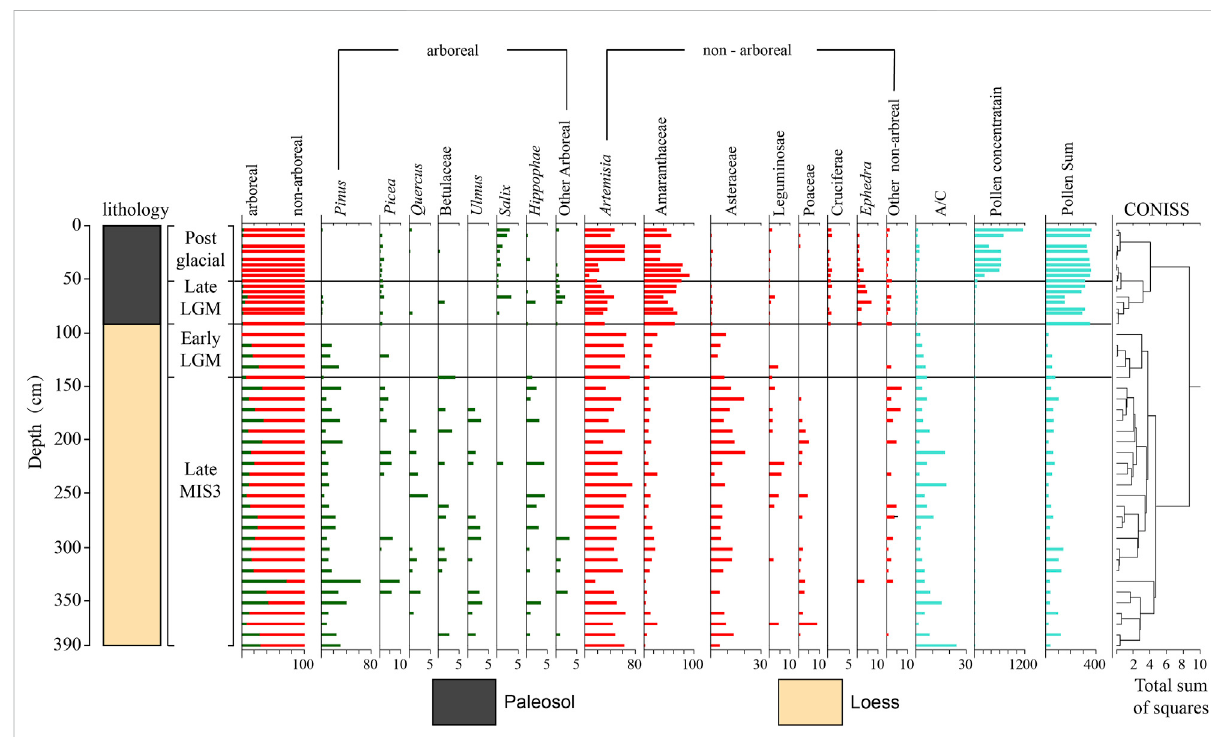
FIGURE 3 PercentagepollendiagramofselectedtaxaofJRTsection.ThefourstagesdividedbytheblacklinearebasedonOSL,grainsize,andtheresults of multi-climate proxies, as described in Section